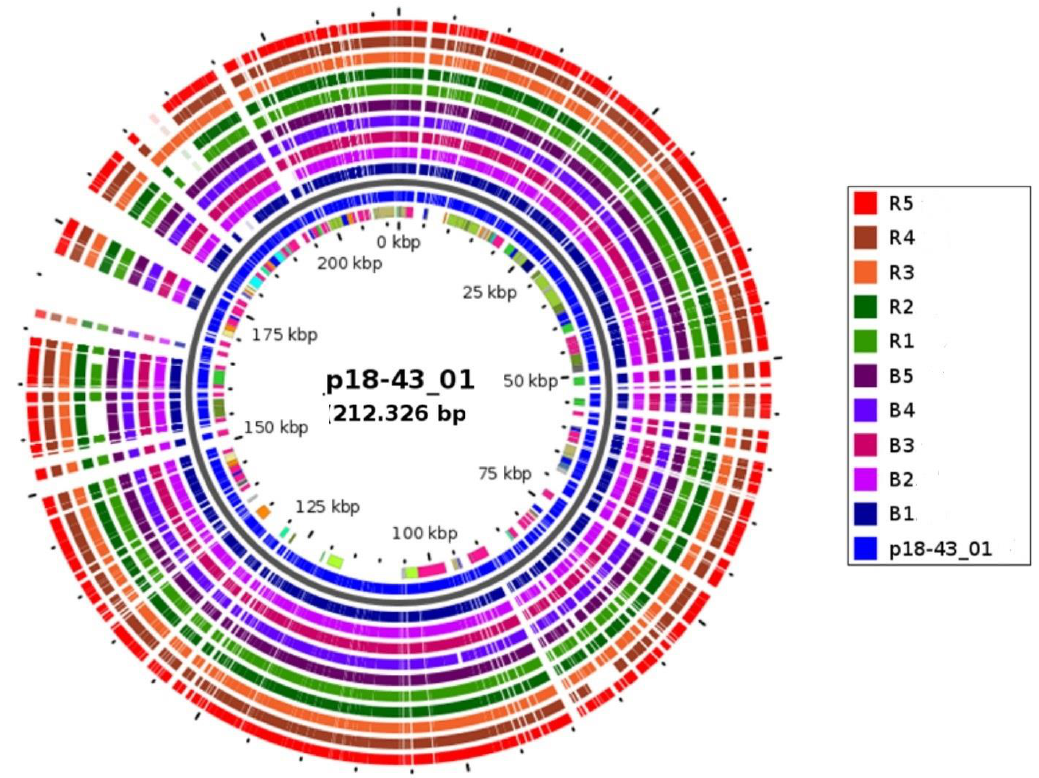
Figure 1. Tracking of plasmid p18-43_01 in NDM-1-encoding CP- K. pneumoniae isolates ( n = 10). The